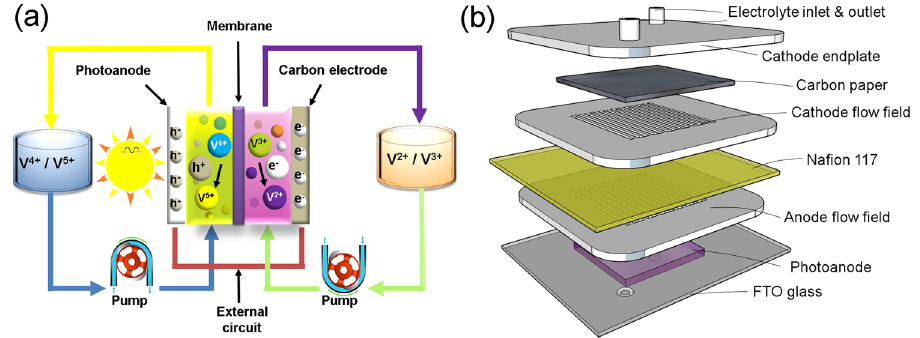
Figure 1. ( a ) Schematic representation of the all-V continuous-flow PESC setup, including the cell, pumps, and electrolyte storage tanks. ( b ) Exploded view of the all-V continuous-flow storage cell. V 4 + and V 5 + denote vanadium species of VO 2 + and VO 2 + , respectively. During operation, two different vanadium redox electrolytes, i.e., VO 2 + and V 3 + (balanced with 3 M H 2 SO 4 and separated by an ion-conducting membrane), are used as the anolyte (in contact with the photoanode) and catholyte (in contact with a carbon-paper cathode), respectively. Under photocharge, reactions at the photoanode and cathode are VO 2 + + H 2 O → VO 2 + + e − + 2H + and V 3 + + e − → V 2 + ,